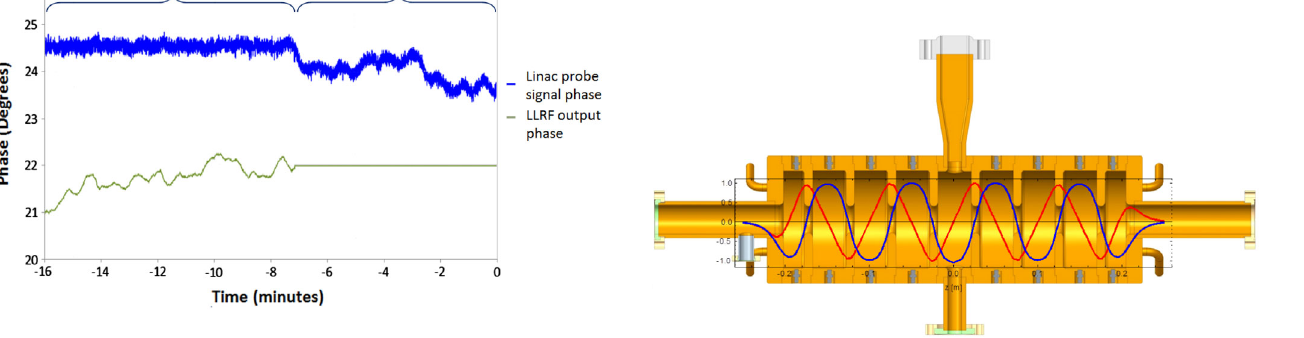
FIG. 24. Normalized on-axis fields through the cavity of the components that contribute to the beam deflection — Re ½ E (cid:4) (blue curve) and Im ½ H x